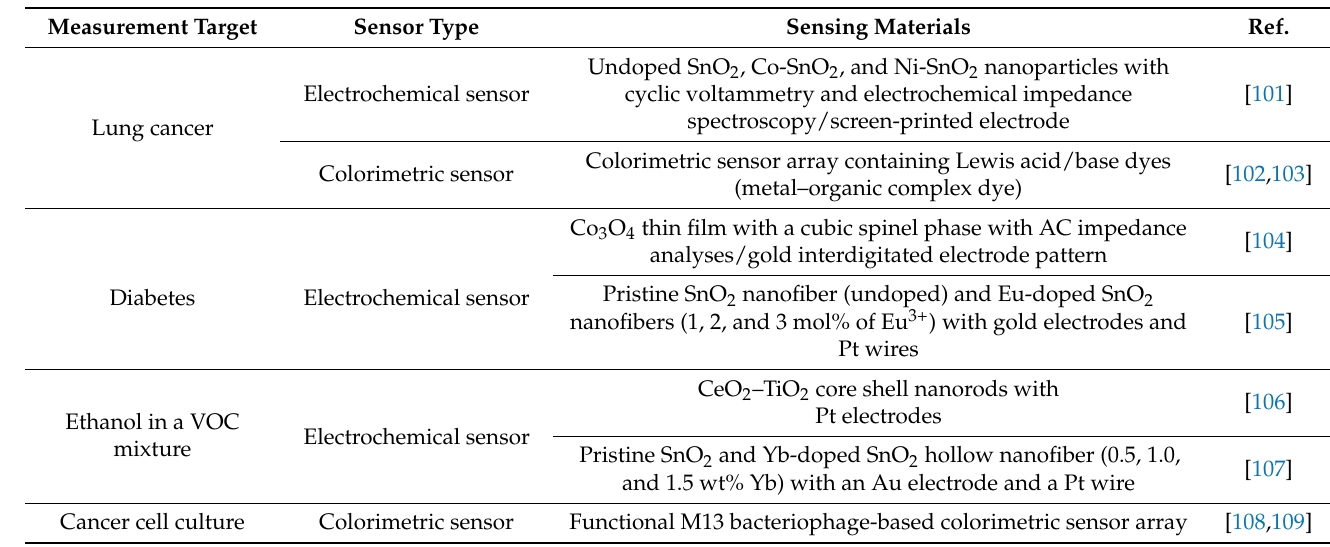
Table 2. Gas sensor technology applicable to future disease